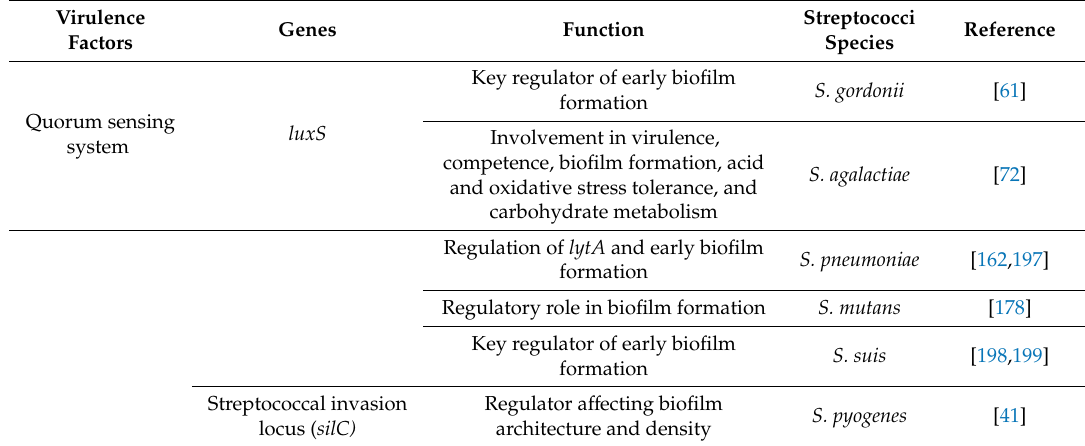
Table 3. List of di ff erent genes present in Streptococcal species that are involved in biofilm formation and act as adhesins, virulence factors, or